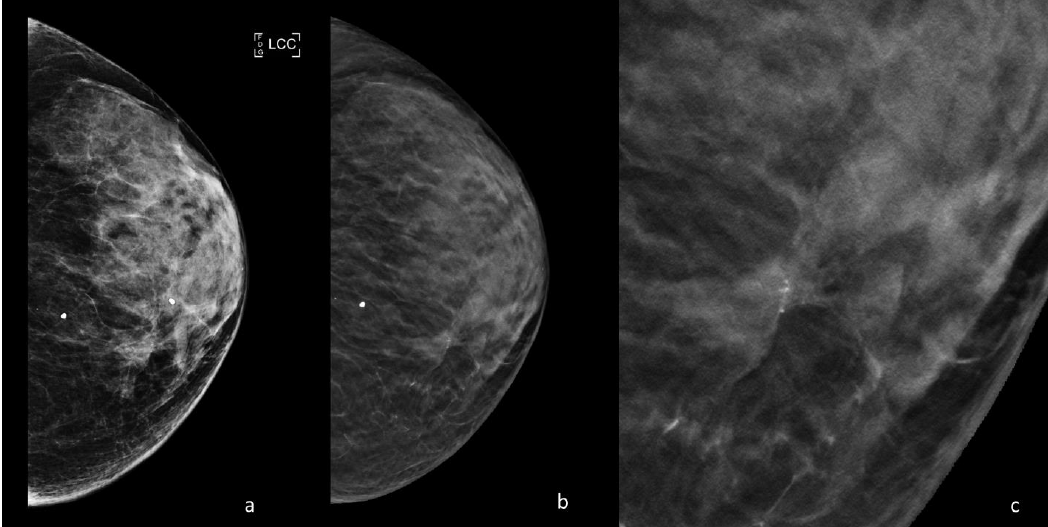
Figure 1. Periodic control with DM and DBT of a 47-year-old patient with a family history of breast cancer. ( a ) DM cranio-caudal left view; breast density BIRADS C; millimetric cluster of microcalcifications in the inner quadrants. ( b ) DBT cranio-caudal left view; in the site of the microcalcifications a parenchymal distortion is appreciated, enhanced by DBT acquisition. (c) Detail of the parenchymal distortion at higher magnification. The distortion with microcalcifications was then biopsied, resulting an invasive ductal carcinoma.